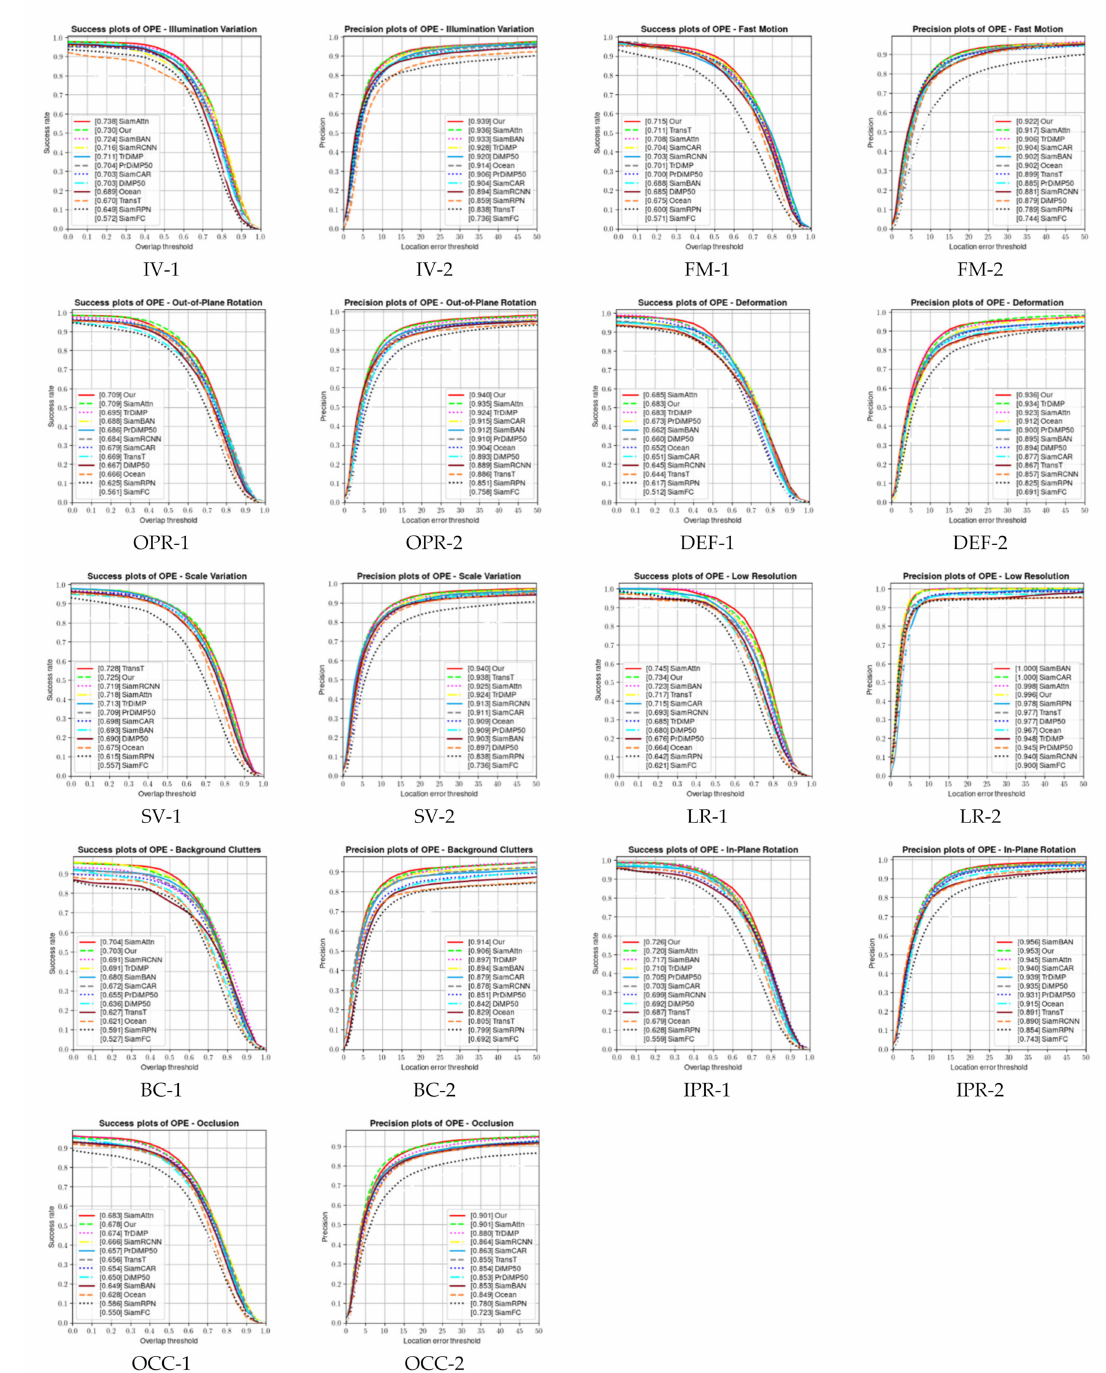
Figure 5. Precision plots and success plots corresponding to some typical scenarios. The OTB2015 dataset was used for the